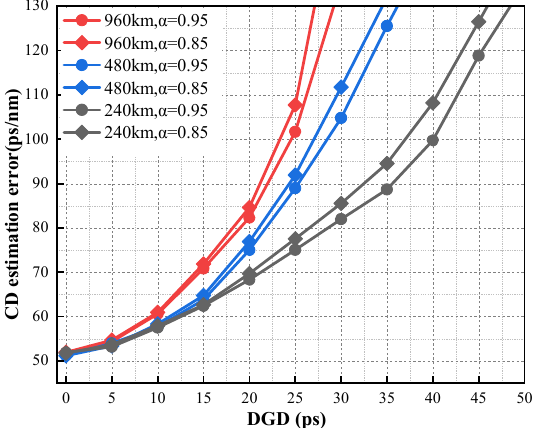
Figure 8. The mean value of the absolute CDE error vs. different DGD.